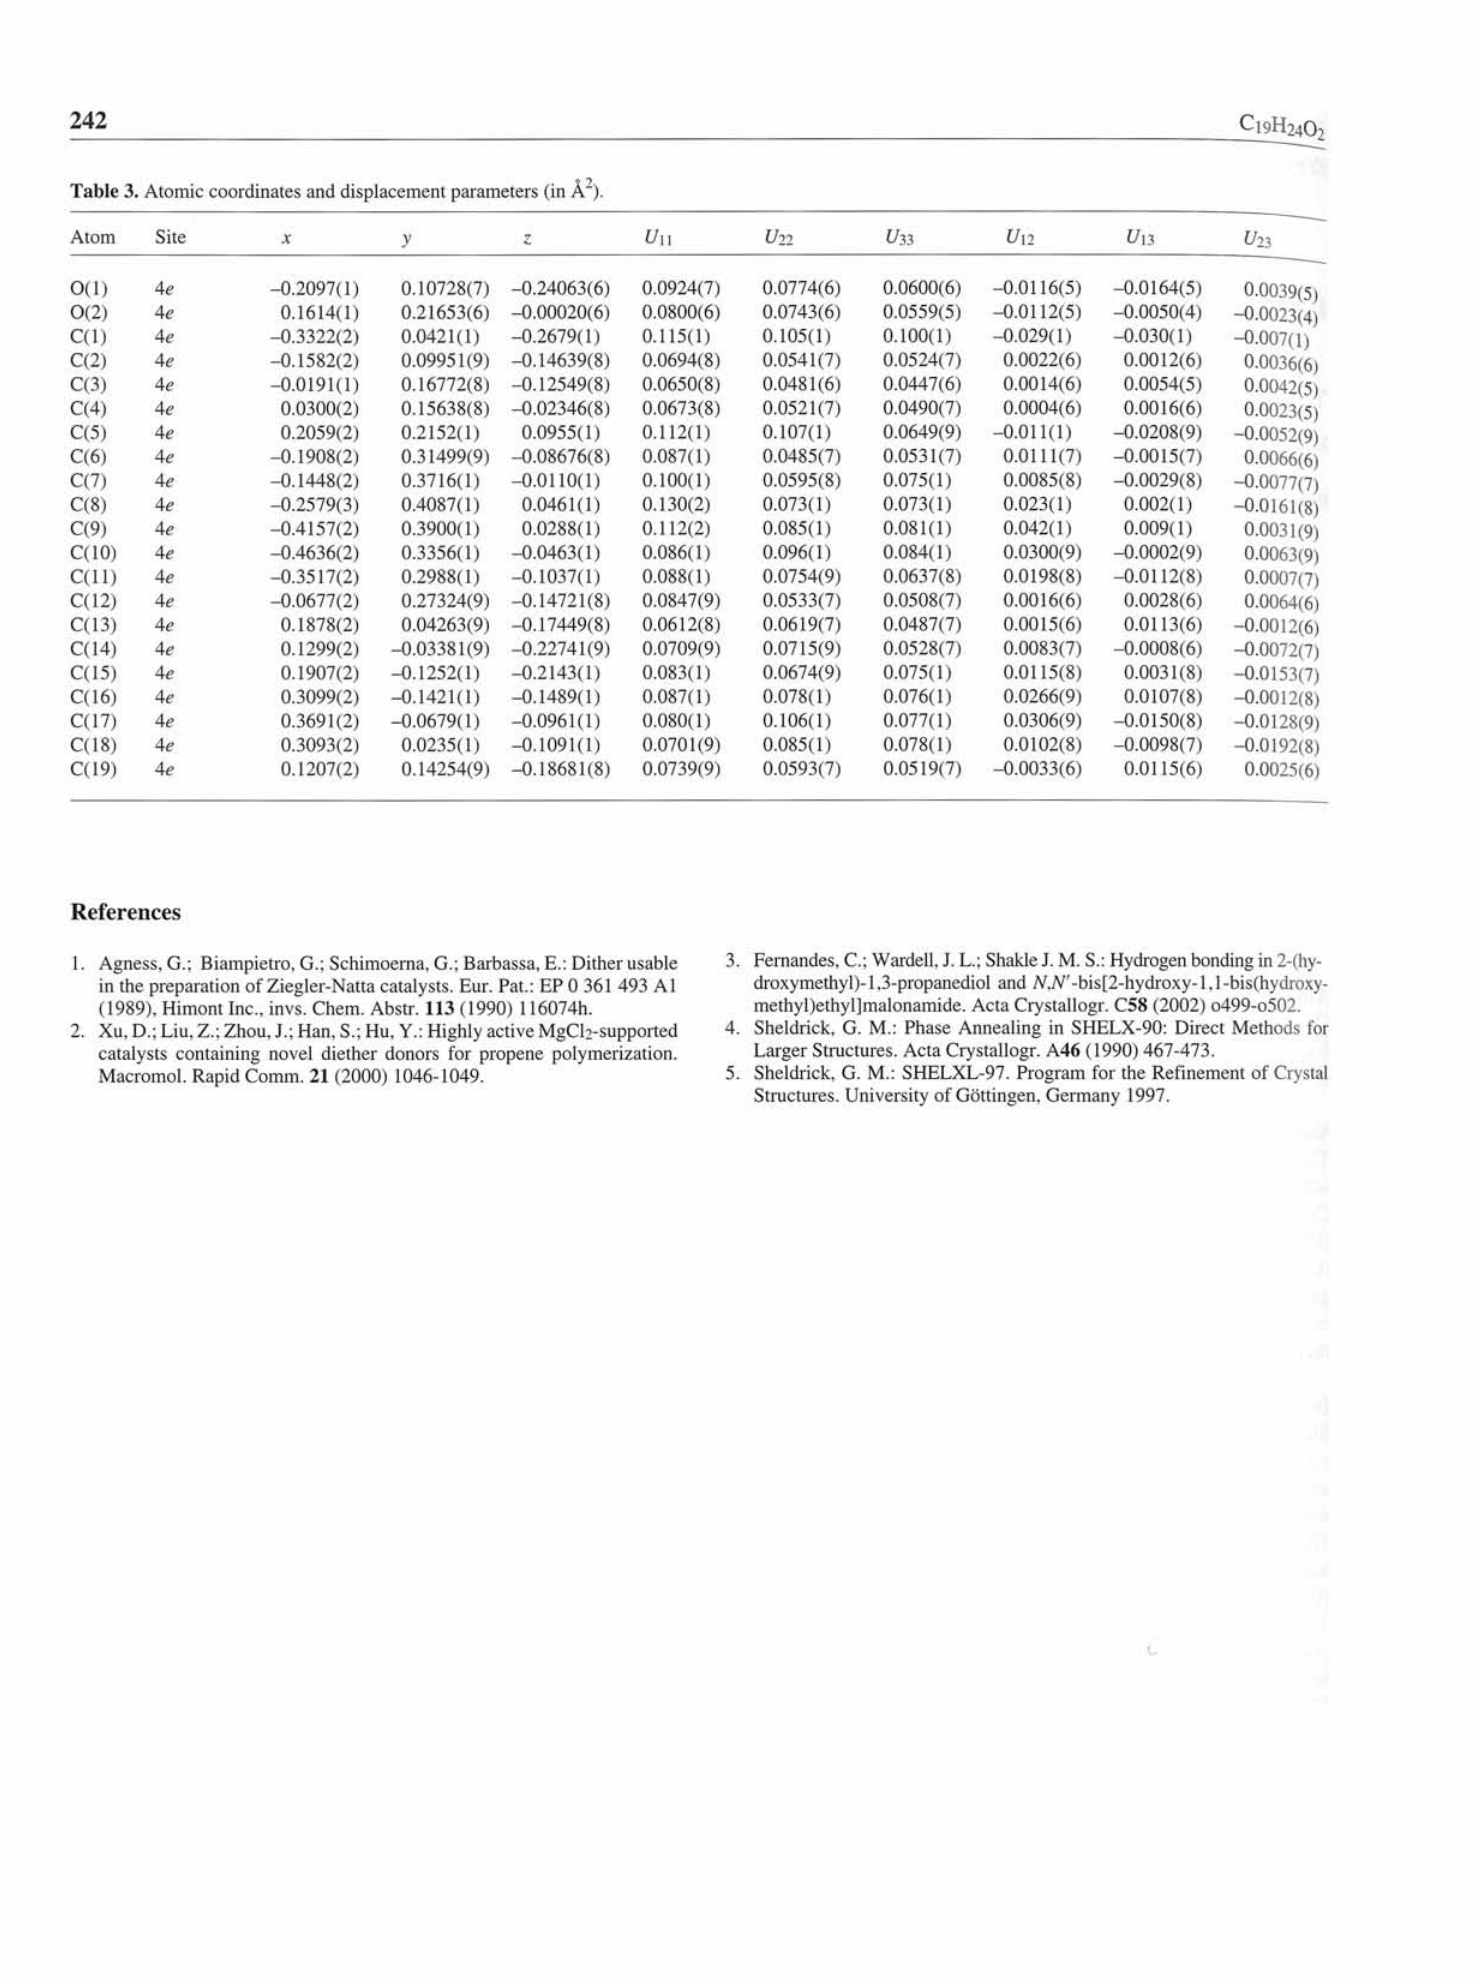
Table 3. Atomic coordinates and displacement parameters (in